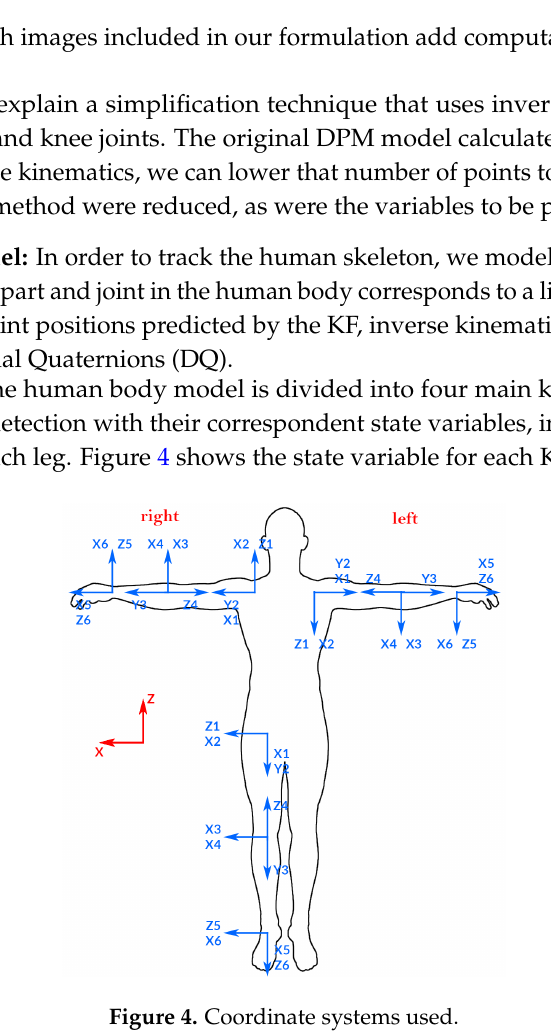
Figure 4. Coordinate systems